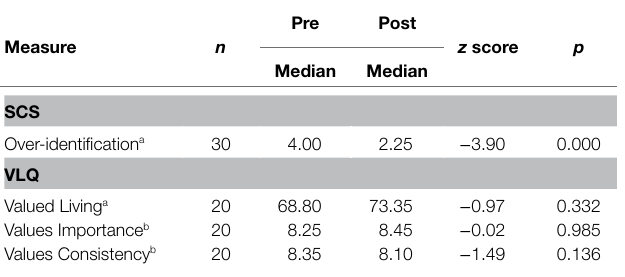
Pre Post z score p Median Median